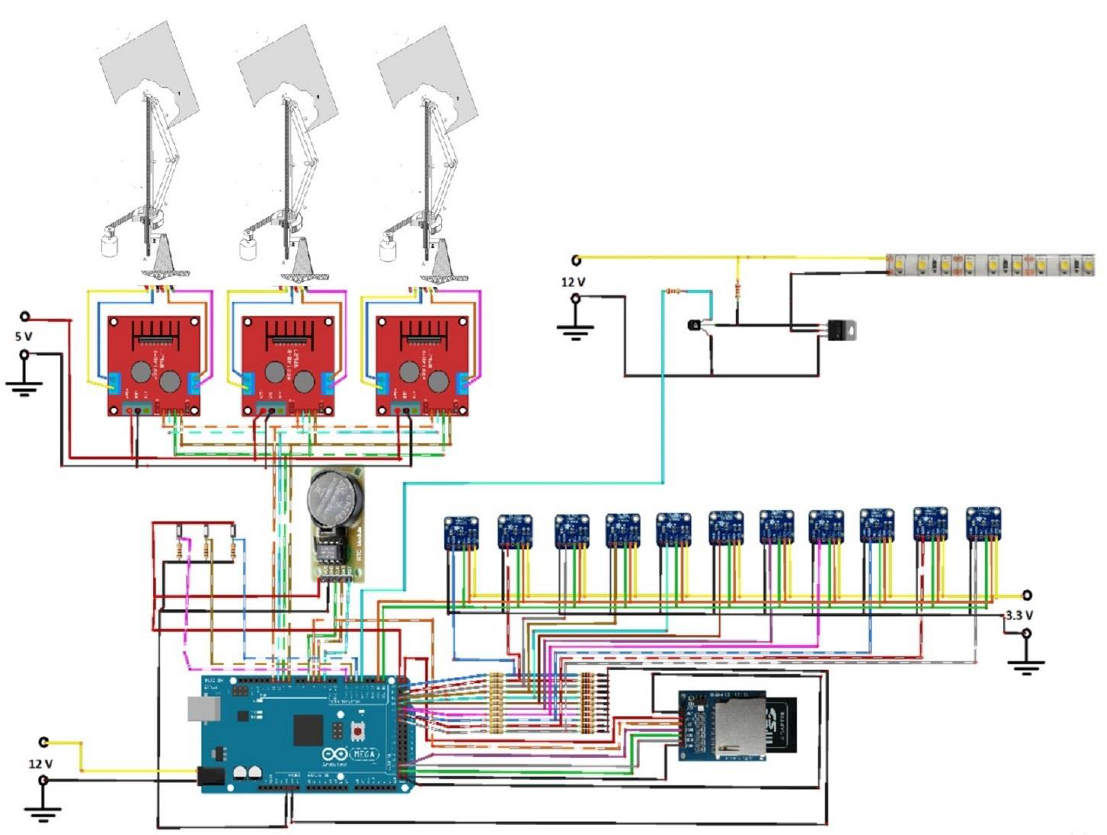
Figure 14. Diagram of connection of the different components to the Arduino Mega 2560 board in charge of the control of the system.